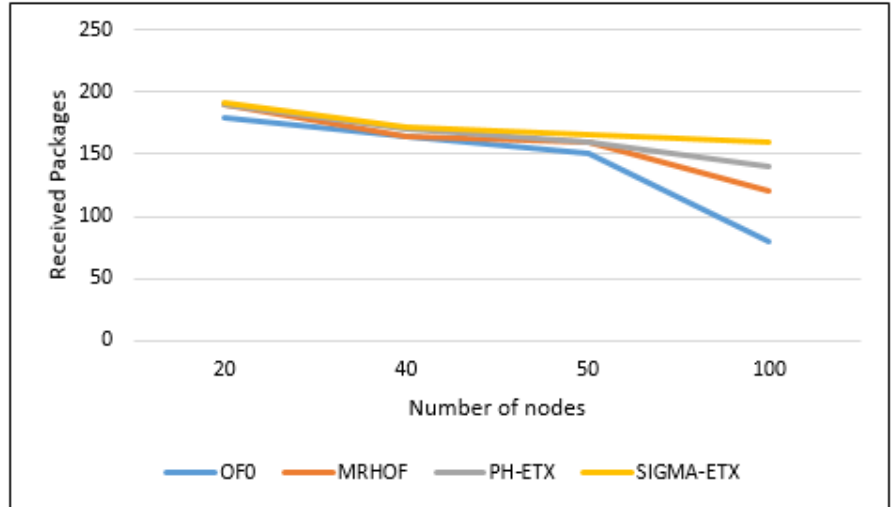
Figure 14. Packet delivery ratio.